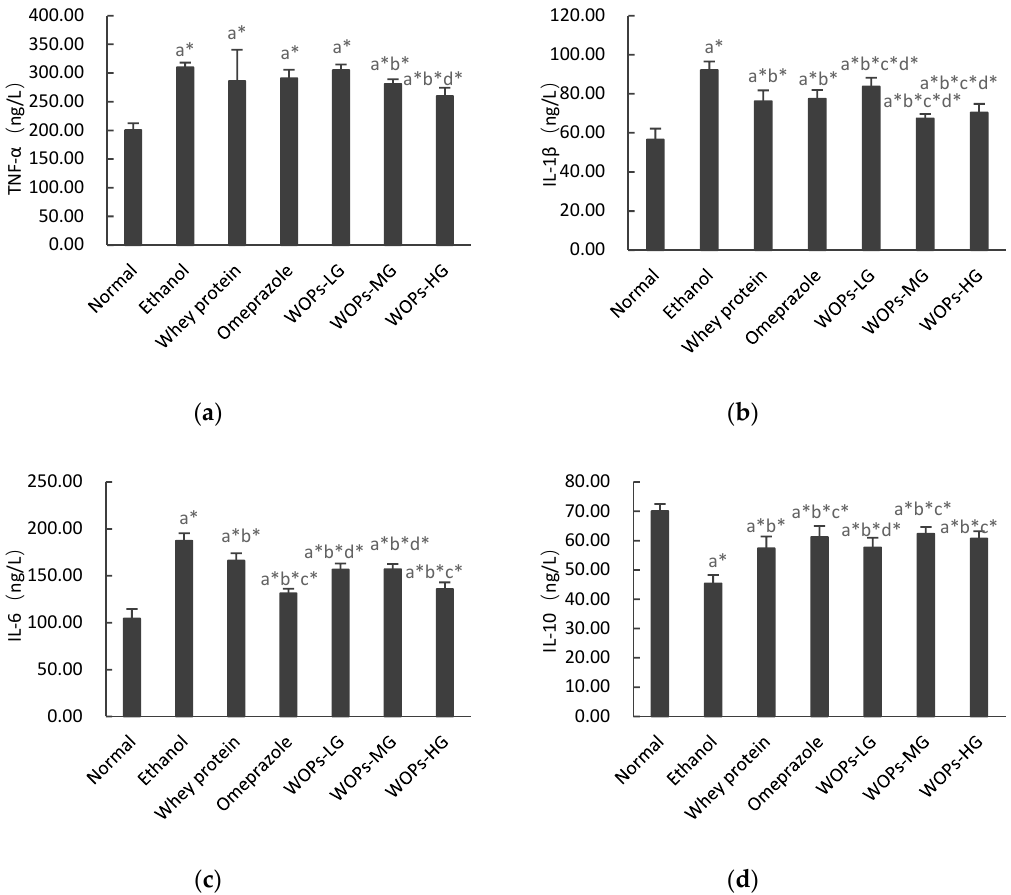
Figure 4. Effects of WOPs on TNF- α ( a ), IL-1 β ( b ), IL-6 ( c ), and IL-10 ( d ) levels in ethanol-induced rats. Data are expressed as mean ± SD ( n = 10); a, b, c, d represent compared with normal group, ethanol group, whey protein group, and omeprazole group, respectively; * p < 0.05 was considered to have statistical differences. Tumor necrosis factor α , TNF- α ; interleukin (IL)-6, IL-6; interleukin (IL)-1 β , IL-1 β ; IL-10, interleukin (IL)-10; WOPs-LG, 220 mg/kg of walnut oligopeptides group; WOPs-MG, 440 mg/kg of walnut oligopeptides group; WOPs-HG, 880 mg/kg of walnut oligopeptides group.